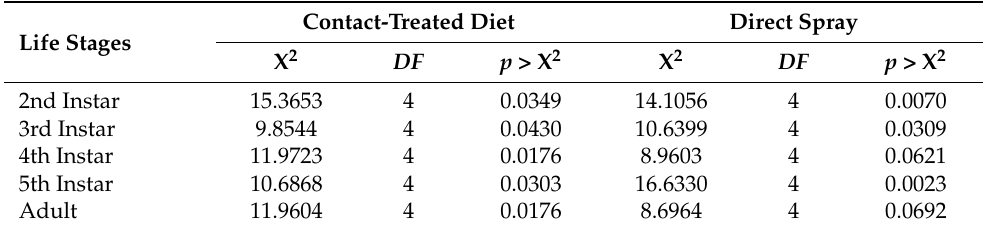
Table 1. Test of Equality over Strata LIFETEST (Wilcoxon-Test) for nymphs and adults of Nezara viridula exposed by contact and direct spray to Beauveria bassiana , Delta native strain NI8 at different concentrations. Survival was scored for 10 d post-exposure.